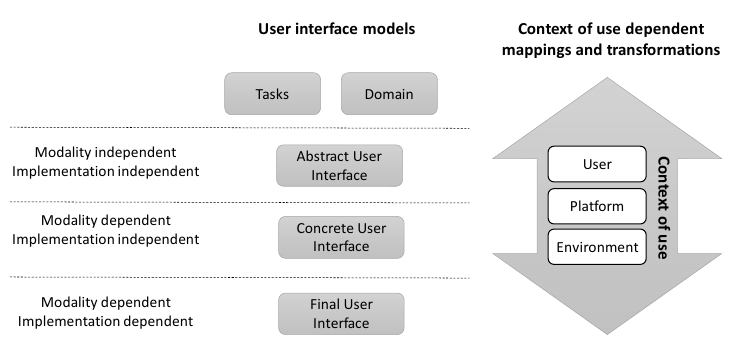
Figure 1. A simplified version of the Cameleon Reference Framework (CRF). Mappings and transformations between levels of abstraction depend on the context of use.